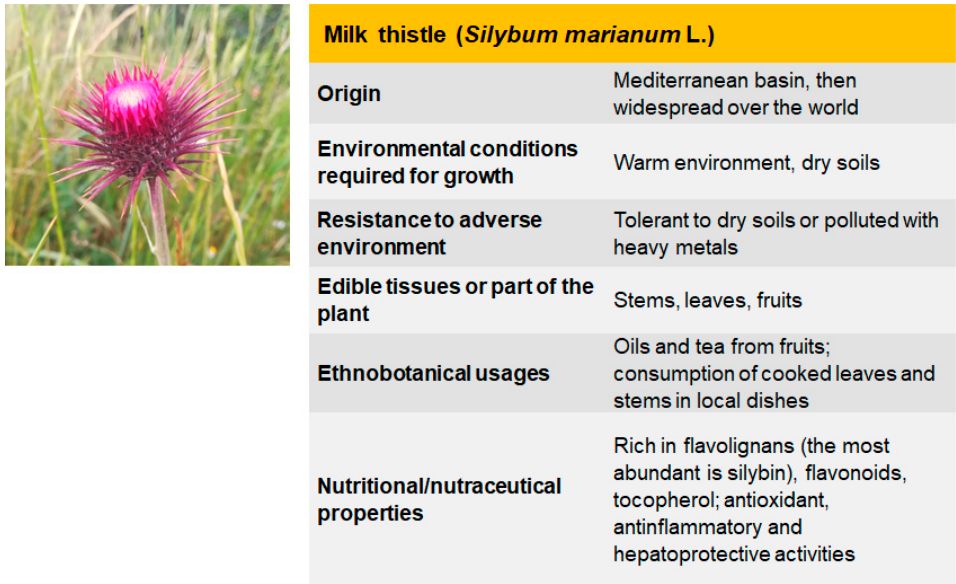
Figure 6. Scheme of the main features of S. marianum . Table 6. Some examples of bioactive compounds in S. marianum .